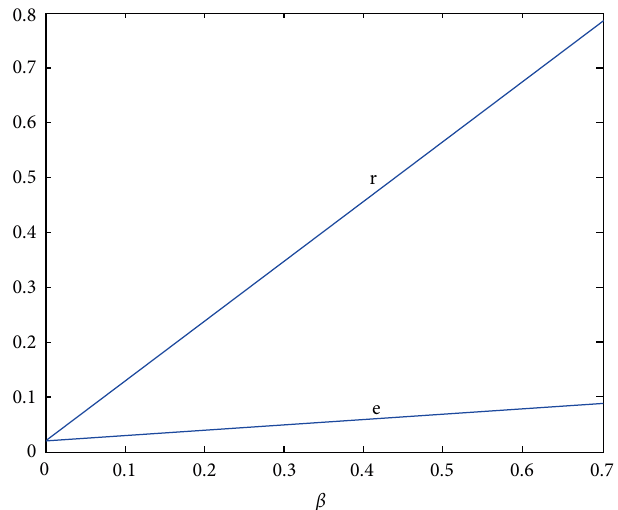
Figure 5: Figure of the coal power plants’ total carbon emission